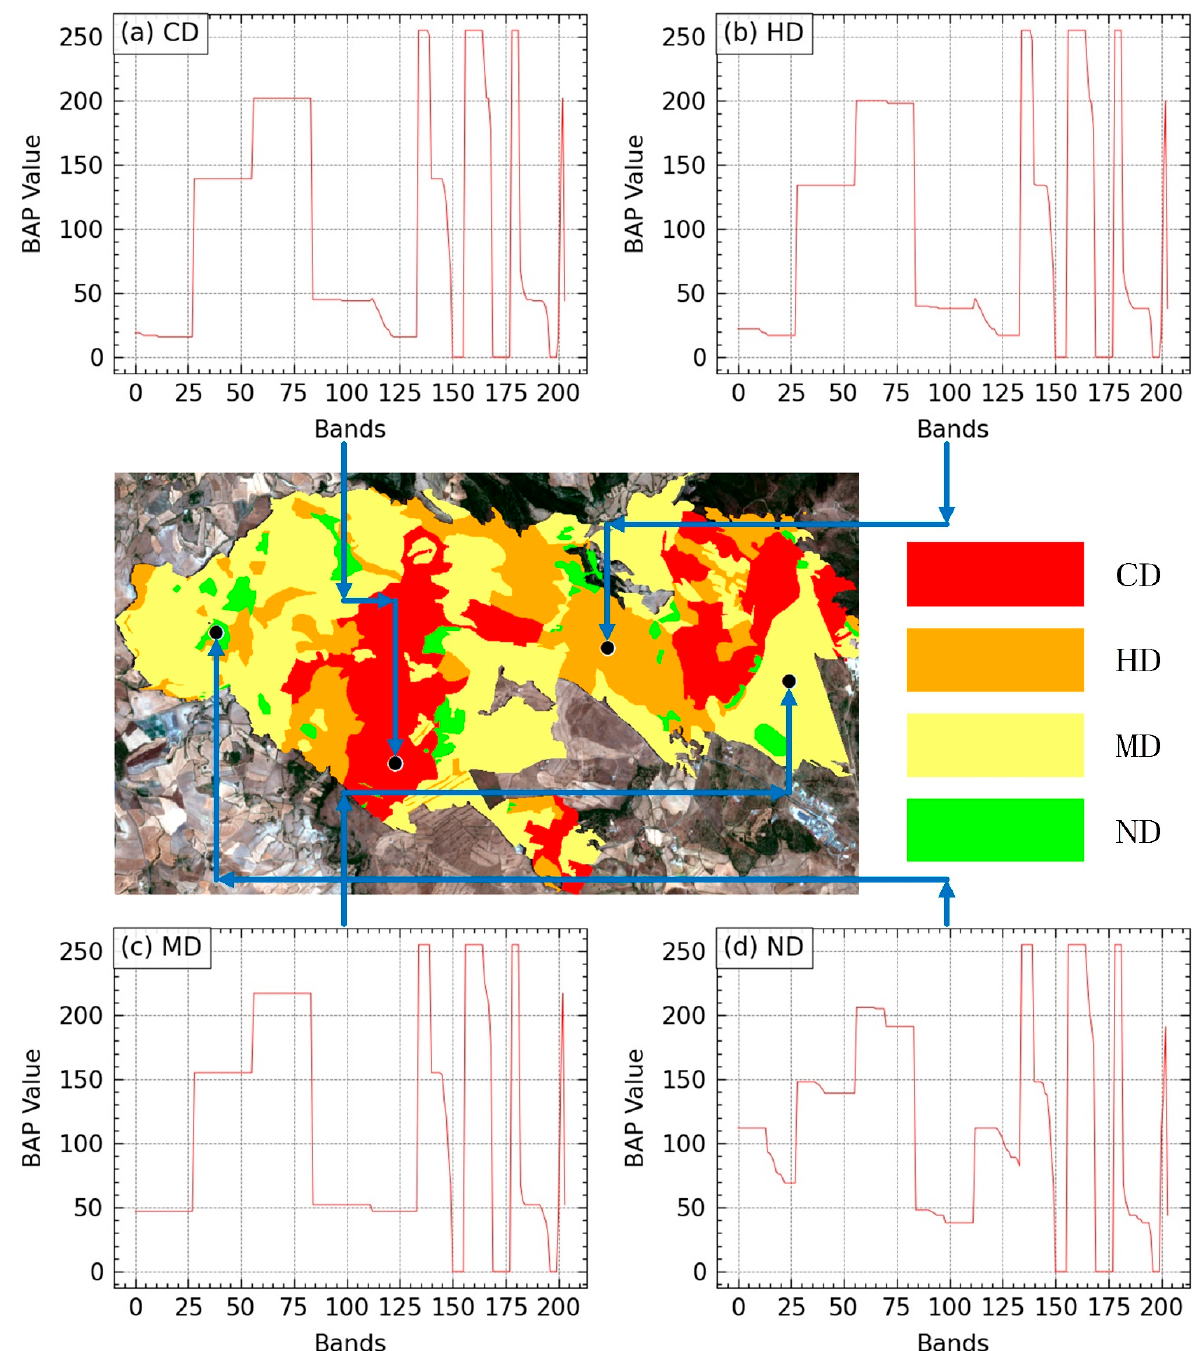
Figure 5. Burn Attribute Profiles (BAP) feature curves for the four classes in the EMSR171 fire: ( a ) CD: Completely Destroyed; ( b ) HD: Highly Damaged; ( c ) MD: Moderately Damaged; ( d ) ND: Neg- ligible to Slight Damage. Shown for each class with one sample point taken randomly, and each band corresponds to a value within